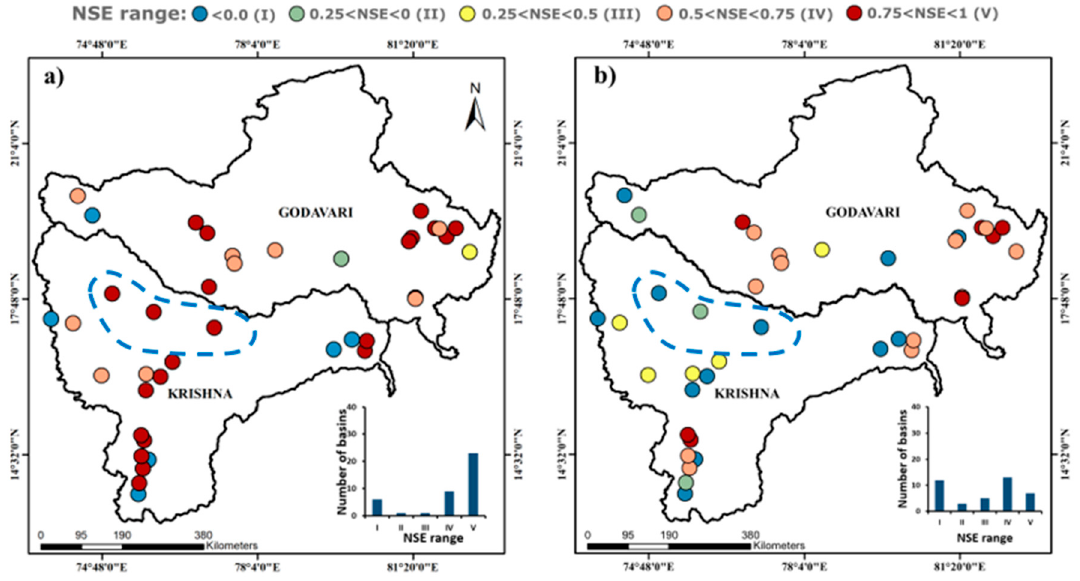
Figure 5. Maps showing spatial distribution of NSE DB ( a ) and NSE IDW ( b ), considering the results from all 40 study basins. The IDW model gives poor performance, particularly in places with low discharge gauging station density (compare the highlighted portions of the two maps), supporting the notion that regionalization models are unreliable in discharge data-scarce regions. The two insets are plots showing NSE range (see the legend on the top) vs. number of study basins, which provides a comparative assessment of the two models.